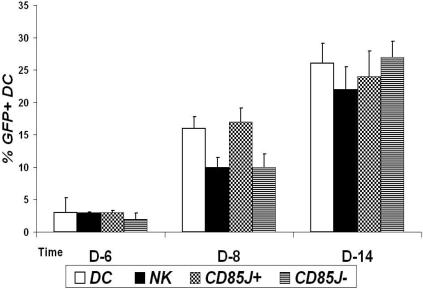
Suppression of HIV-1 replication in DC by CD85j+ NK cells requires cell-to-cell contact and does not apparently depend on soluble factors.Total NK cells or the CD85j+ or CD85j− subsets were cocultured with HIV-1Bal-infected MDDC in the bottom of Transwell wells. HIV/GFP-infected MDDC were added to the inserts and GFP expression was monitored over time. The percentages of NK cells expressing GFP in the inserts placed on the different cell cultures are shown: MDDC cultures without NK cells (DC), with total NK cells (NK), with CD85j+ NK cells (CD85j+) and with CD85j− NK cells (CD85j−). Means+SE of 4 independent experiments. Significant differences between HIV-1/GFP-infected MDDC in transwell on MDDC/NK cocultures and on MDDC alone * p<0.05.